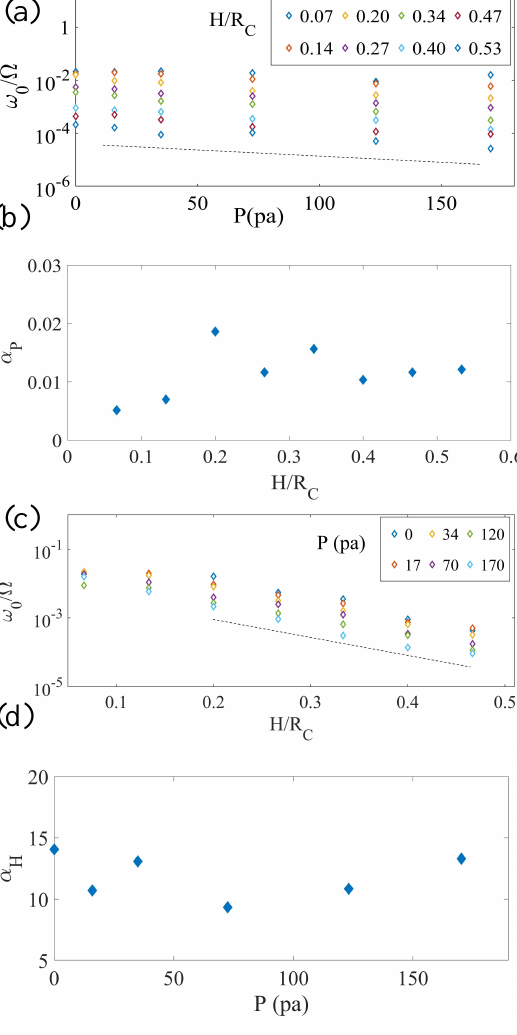
Figure 3. (a) ω 0 / Ω in term of P for increasing values of the filling height H / R c from 0 . 07 to 0 . 53. (b) The decay exponent α P of the tail of ω 0 − P curves at di ff erent values of H . (c) ω 0 / Ω in term of H / R c for increasing values of the external pressure P from 0 to 170 pa. (d) The decay exponent α H of the tail of ω 0 − H curves at di ff erent values of P . The dotted lines indicate an exponential decay as a guide to the eye.